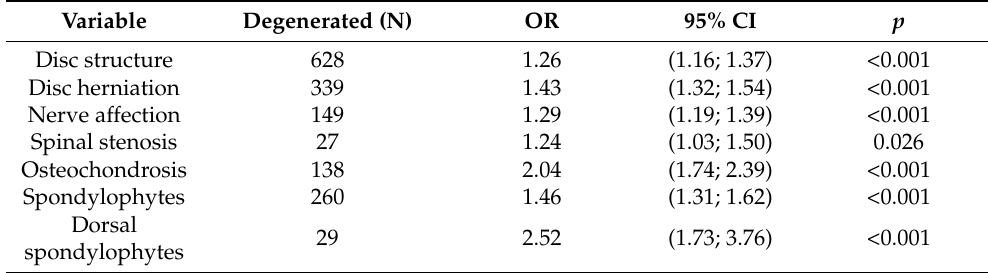
Table 7. Influence of the height of the disc segments (per mm decrease in disc segment) on the seven aspects of degeneration considered in the